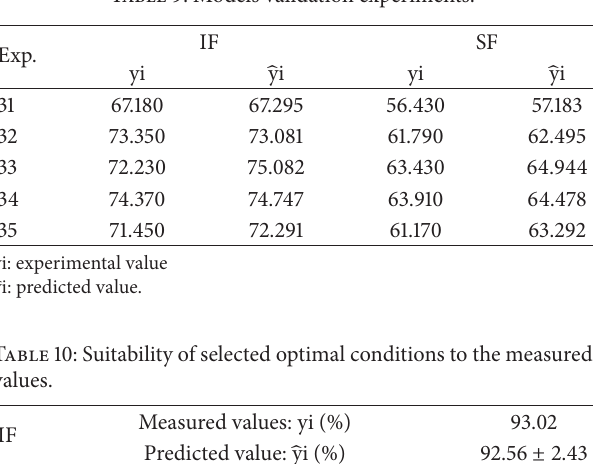
Table 9: Models validation experiments.